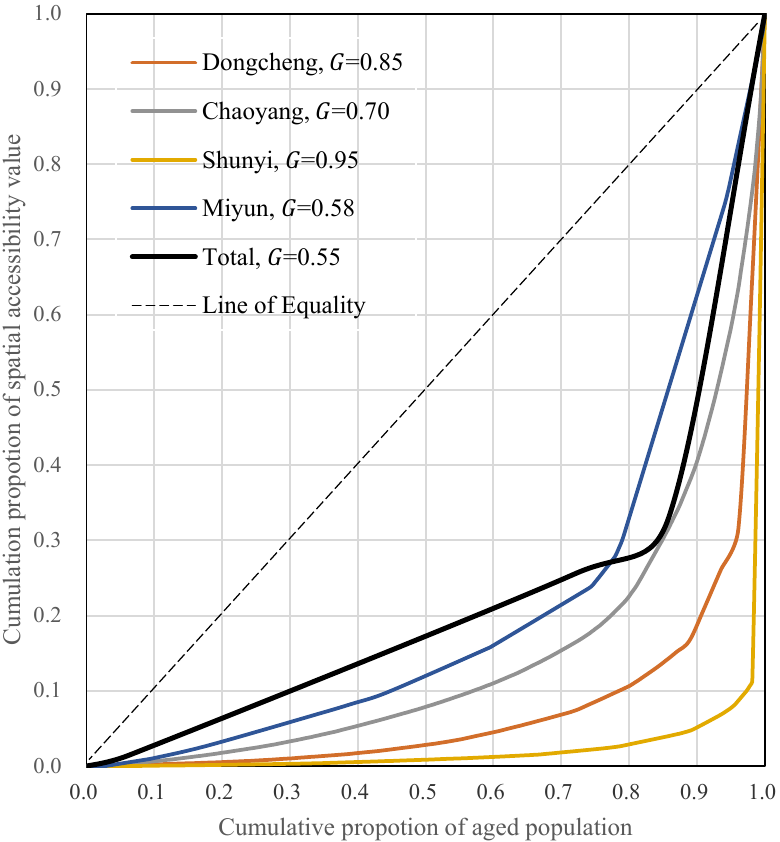
Figure 6. Lorenz curves and Gini coefficients for spatial accessibility of community hospitals by the aged population in four districts.